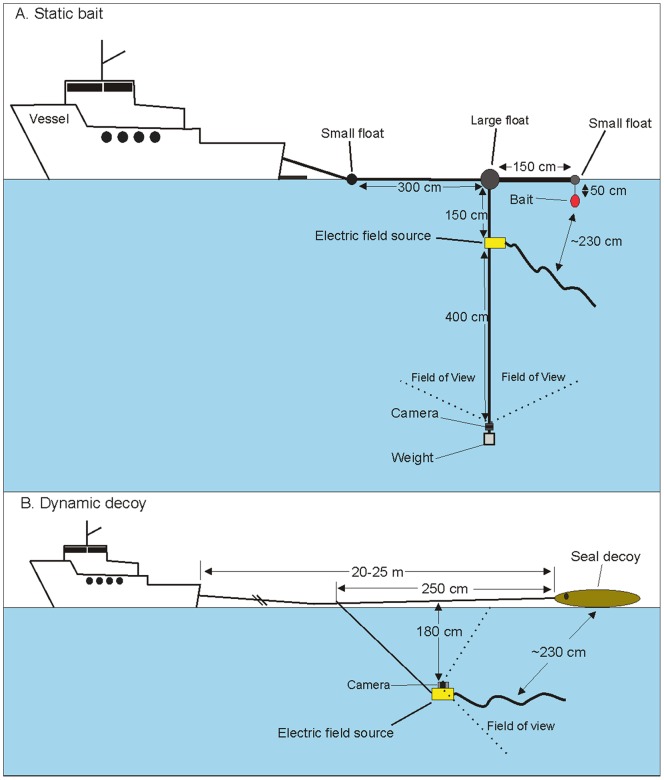
Schematic representation of (A) the experimental set-up used to test the effects of an electric field during static bait trials at North Neptune Island, and (B) the experimental set-up used with the towed seal decoy at Seal Island off South Africa.Reproduced and modified with permission from [52].